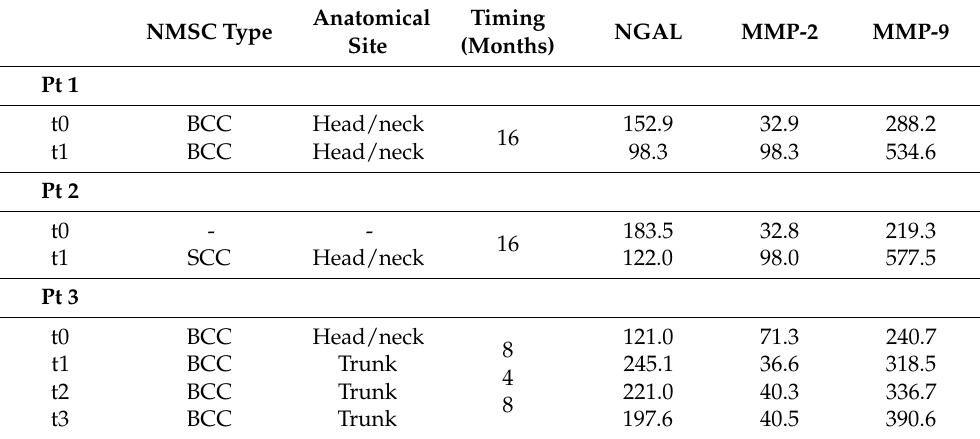
Table 7. Clinical and laboratory characteristics of patients with NMSC at